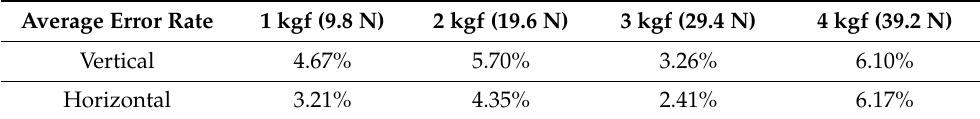
Table 3. Print line width average error rate according to the printing